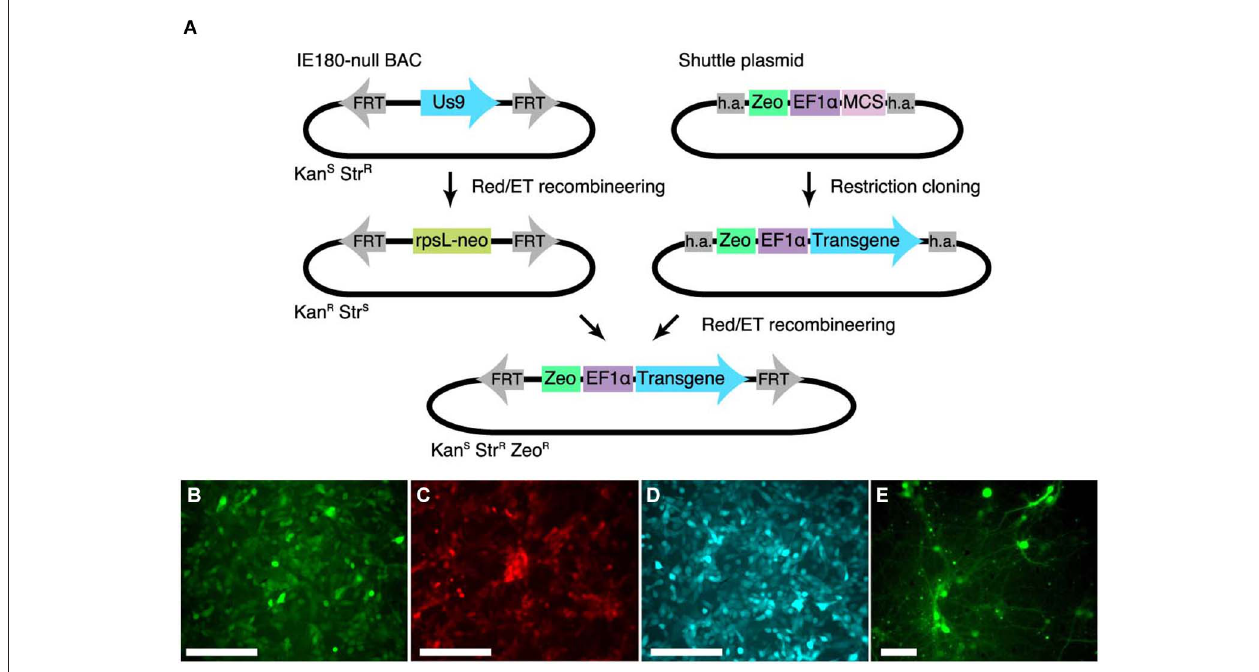
using standardized primers and inserted into the IE180-null BAC using recombineering. (B–D) PK15 cells infected with PRV strains expressing EGFP (PRV HKO128), mCherry (PRV HKO242) and ECFP (PRV HKO243). (E) Dissociated neurons infected with PRV HKO128, at 3 weeks post